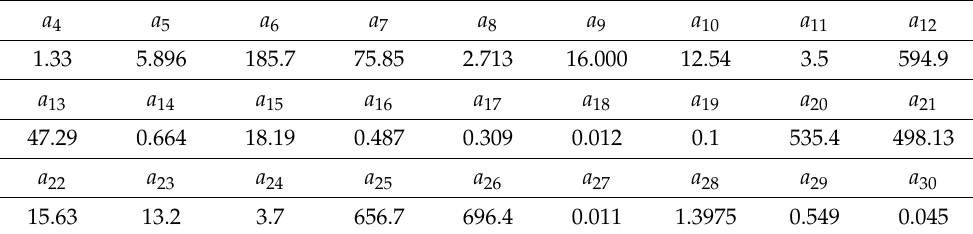
Table 8. Optimal coefficients in the phase transformation model for steel